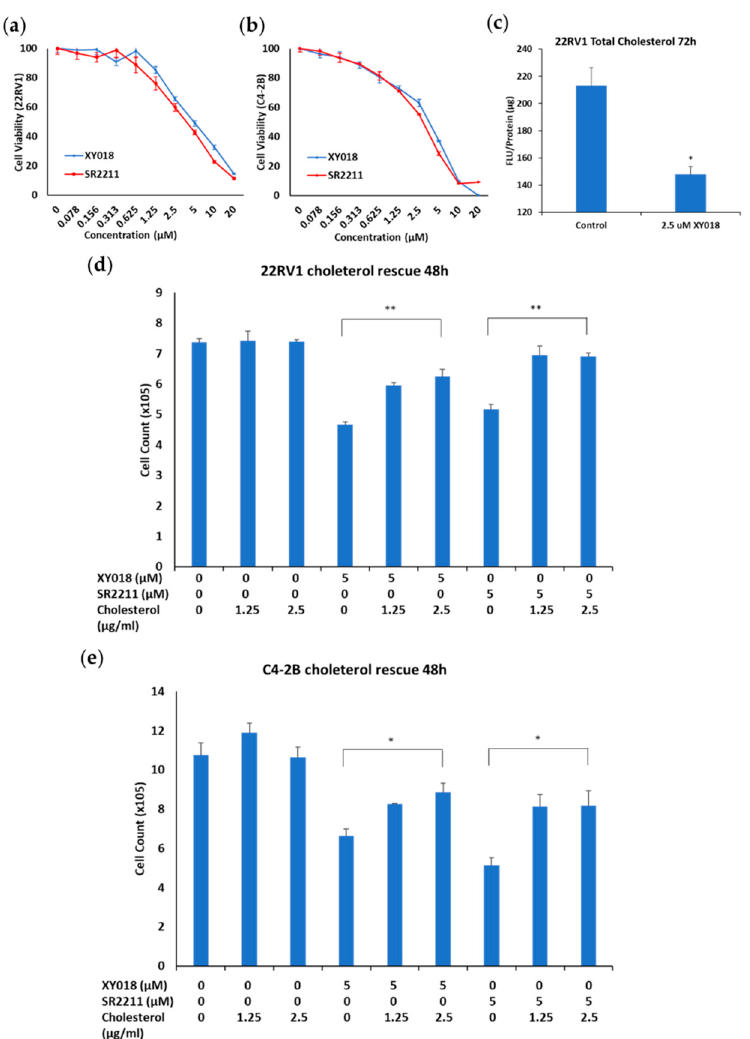
Figure 1. ROR γ antagonists inhibit mCRPC cell growth and survival by decreasing intracellular cholesterol levels. ( a , b ) Cell viability, measured by Cell-Titer GLO (Promega) of 22Rv1 ( a ) and C4- 2B ( b ) cells treated with the indicated concentration of ROR γ antagonists XY018 and SR2211 for 4 d. ( c ) Total cholesterol levels in relative florescent units/protein, measured by Amplex TM Red Cholesterol Assay Kit of 22Rv1 cells treated with indicated concentration of XY018 for 72 h. ( d , e ) Cell numbers of 22Rv1 ( d ) and C4-2B ( e ) cells treated with indicated concentration of XY018, SR2211, and cholesterol for 48 h. Data are shown as mean ± s.d. n = 3. Student’s t test. * p < 0.05, ** p